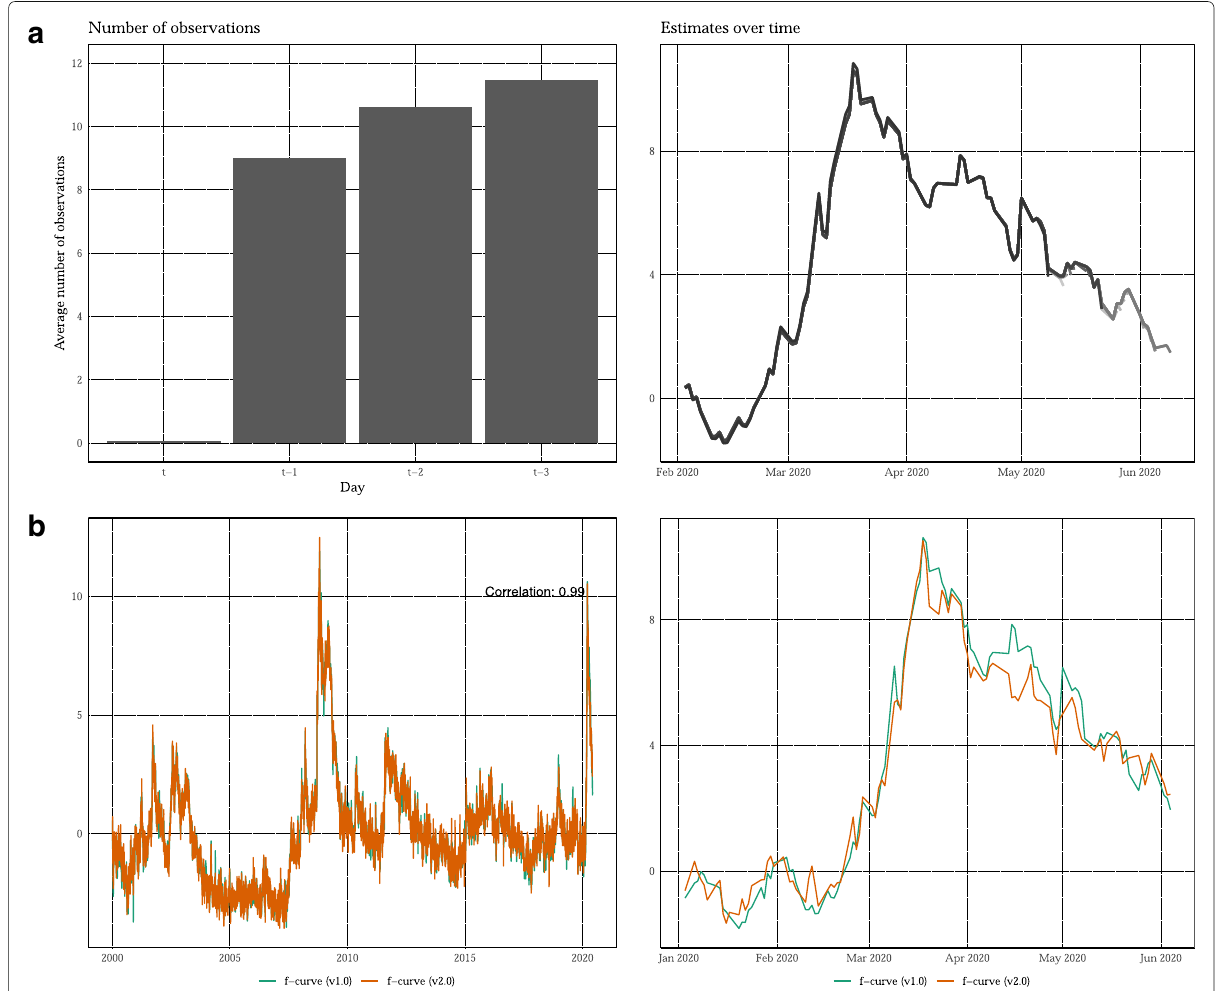
Fig. 5 Real-time results since initial version of the f -curve. Panel a : average number of observations available for calculation the f -curve (left figure). The different shades of gray represent estimates over time from May 11, 2020, to May 29, 2020 (right figure). Panel b : Estimates of the f -curve using the methodology in the Working Paper (v1.0) and the current version